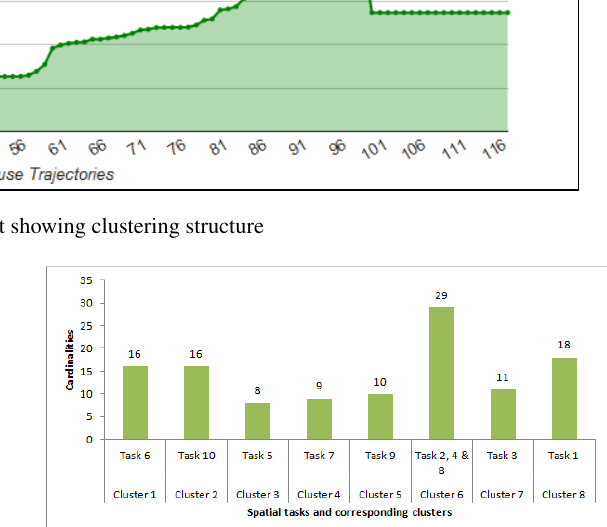
Figure 6: Spatial task validation relative to cluster cardinalities put values. Based on the above parameters, an OPTICS plot was obtained as shown in Figure 4. This graph indicates 8 clusters